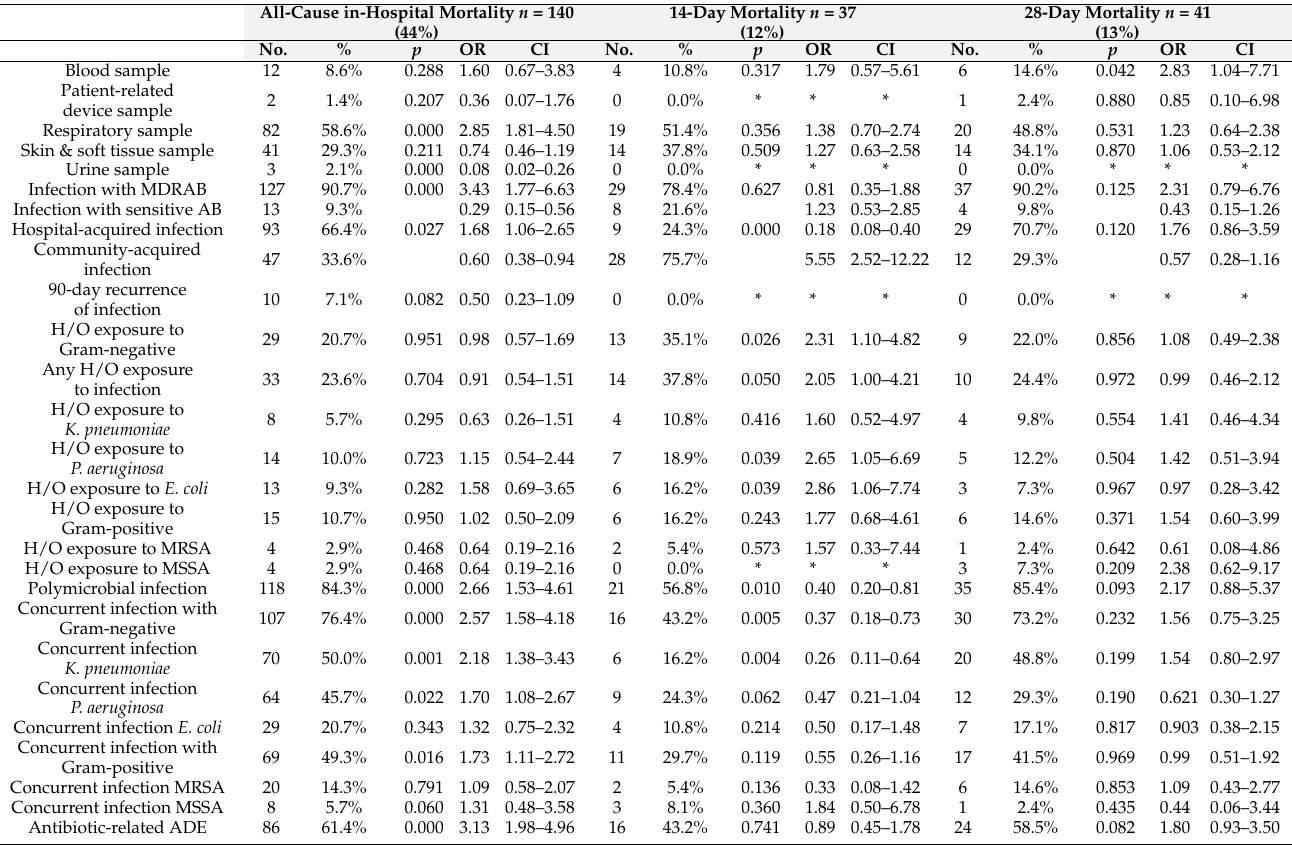
Table 3. Infection-related details versus mortality rates (Binary logistic